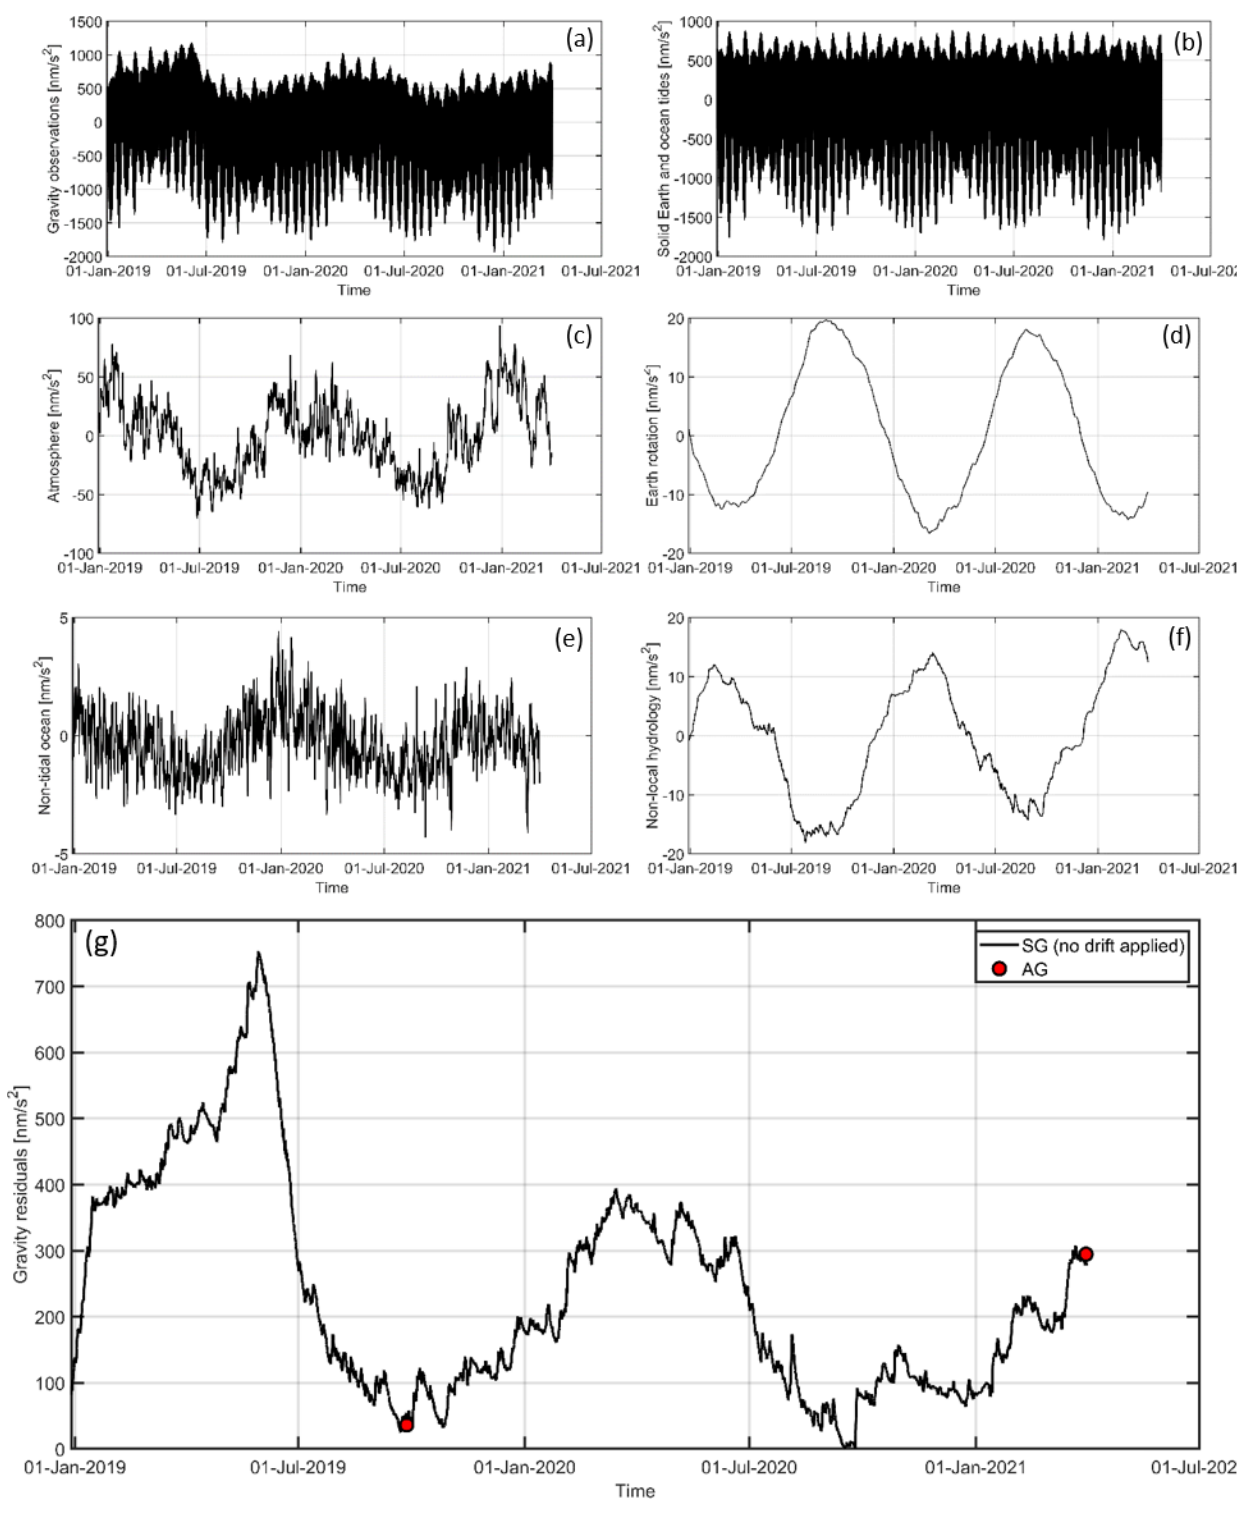
Figure 3. Signal separation from gravity observations (a) to gravity residuals (g) , including two absolute measurements (red circles) by reducing gravity variations induced by solid Earth and ocean tides (b) , atmospheric mass redistributions (c) , Earth rotation (d) , non-tidal ocean (e) and non-local hydrological mass redistributions (f) . Please note the different scaling of the